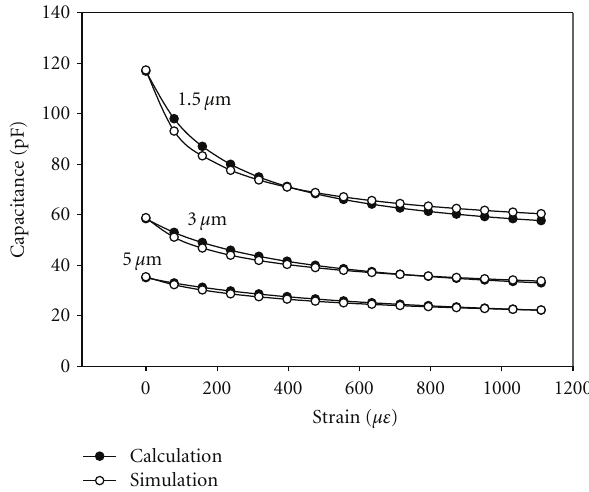
Figure 5: Capacitance output for 1.5 μ m, 3 μ m, and 5 μ m electrodes gap.